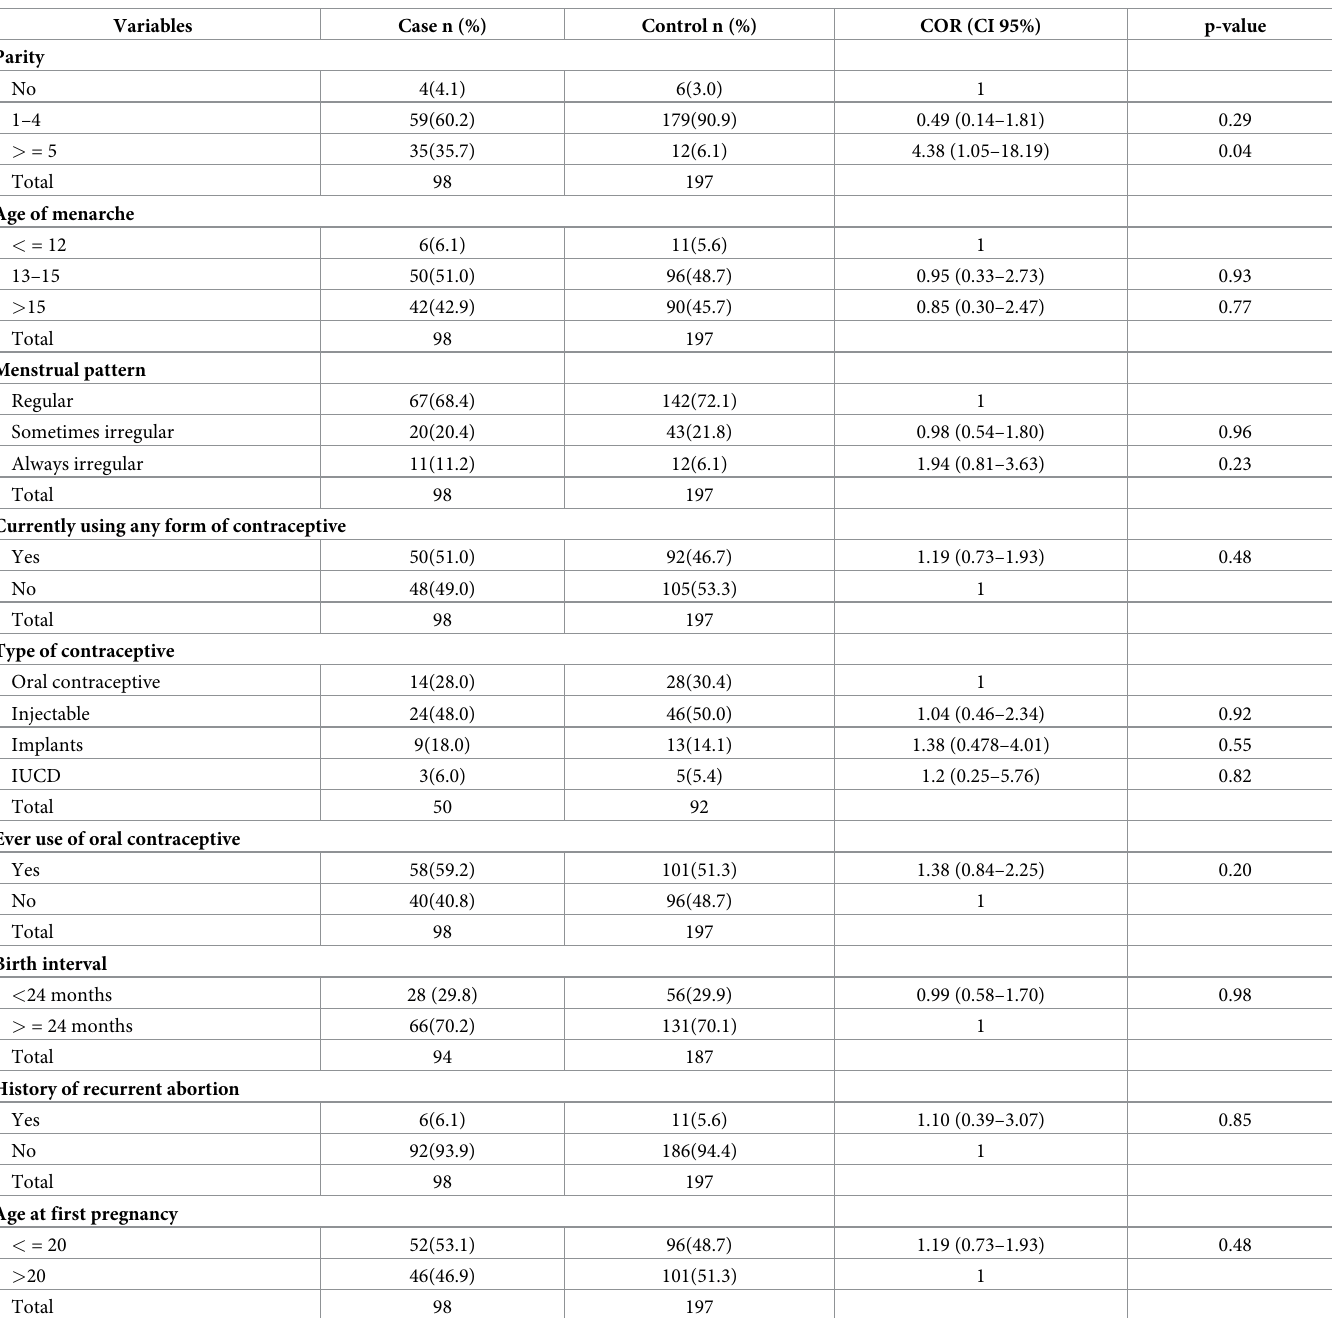
Table 2. Reproductive characteristics of women screened for cervical cancer in south Ethiopia,